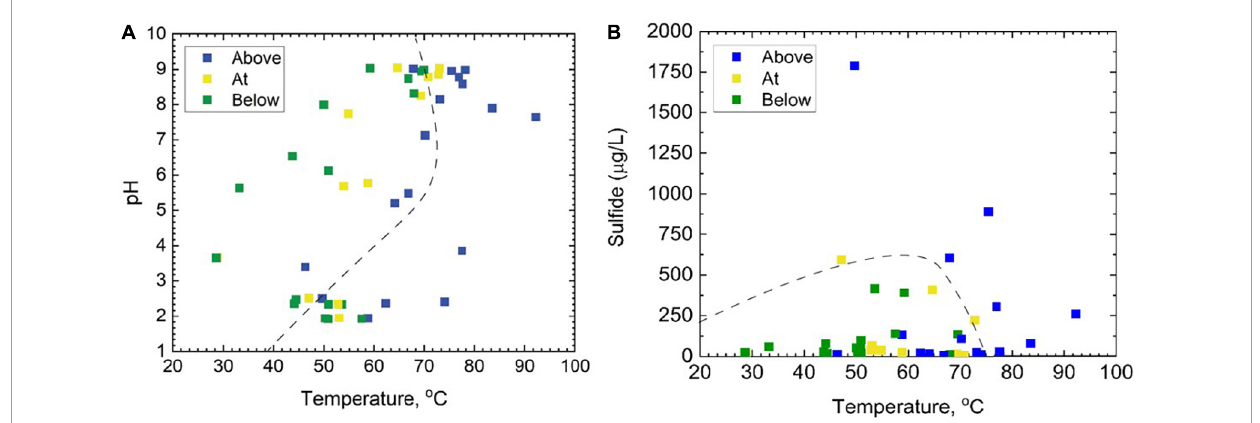
FIGURE2 A total of 46 samples taken from the outflows of 12 separate hot springs above, at, and below the photosynthetic fringe, as determined by linear discriminant analysis, displayed as functions of (A) pH and temperature, and (B) total dissolved sulfide and temperature. In both panels (A,B) , the dashed line represents the photosynthetic limits defined by Cox et al.